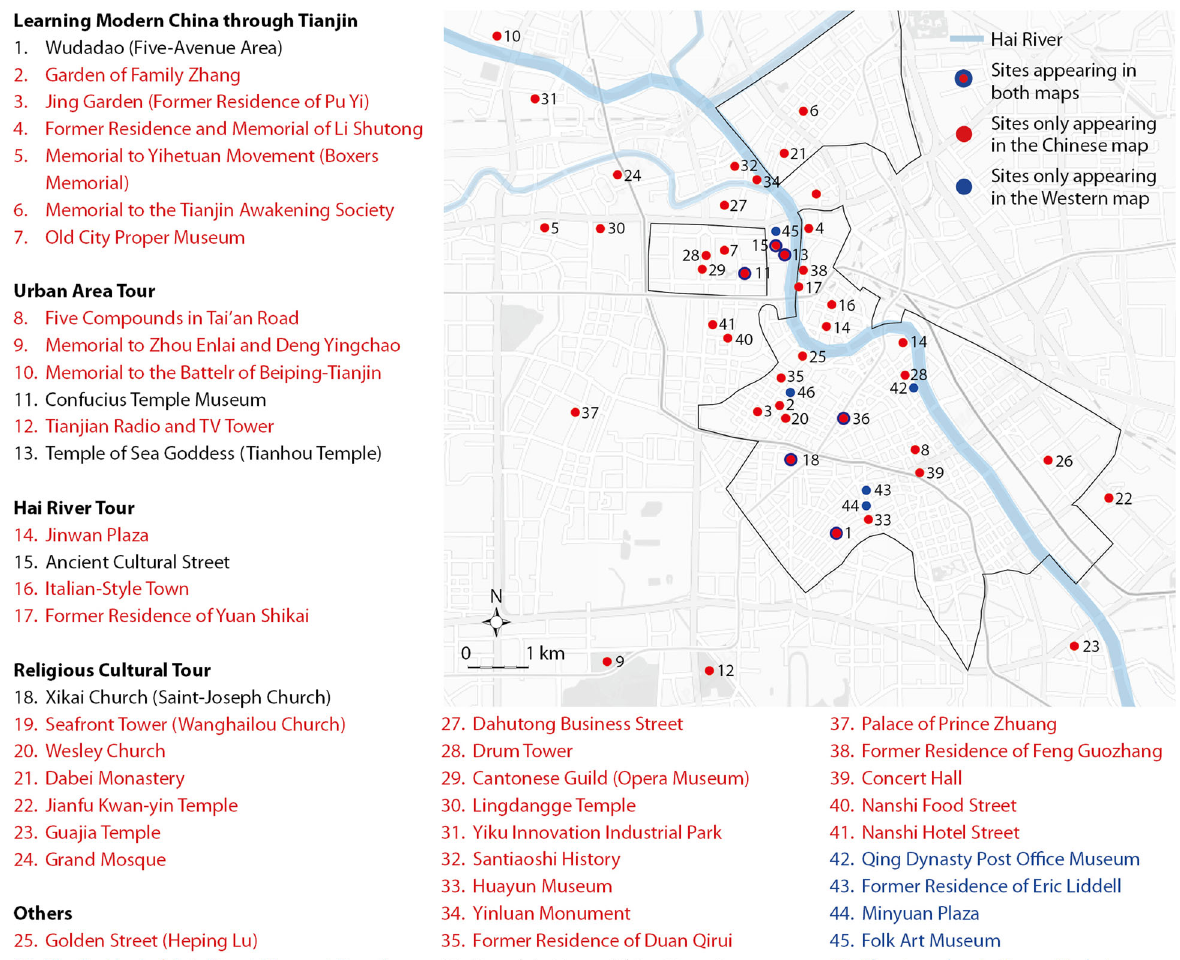
Fig. 9 Comparative map, illustrating the sites appearing in the map of the Tianjin Tourism Bureau vs. those appearing in the Lonely Planet ’ s map, both published in 2017 (Source: Yue Lu,